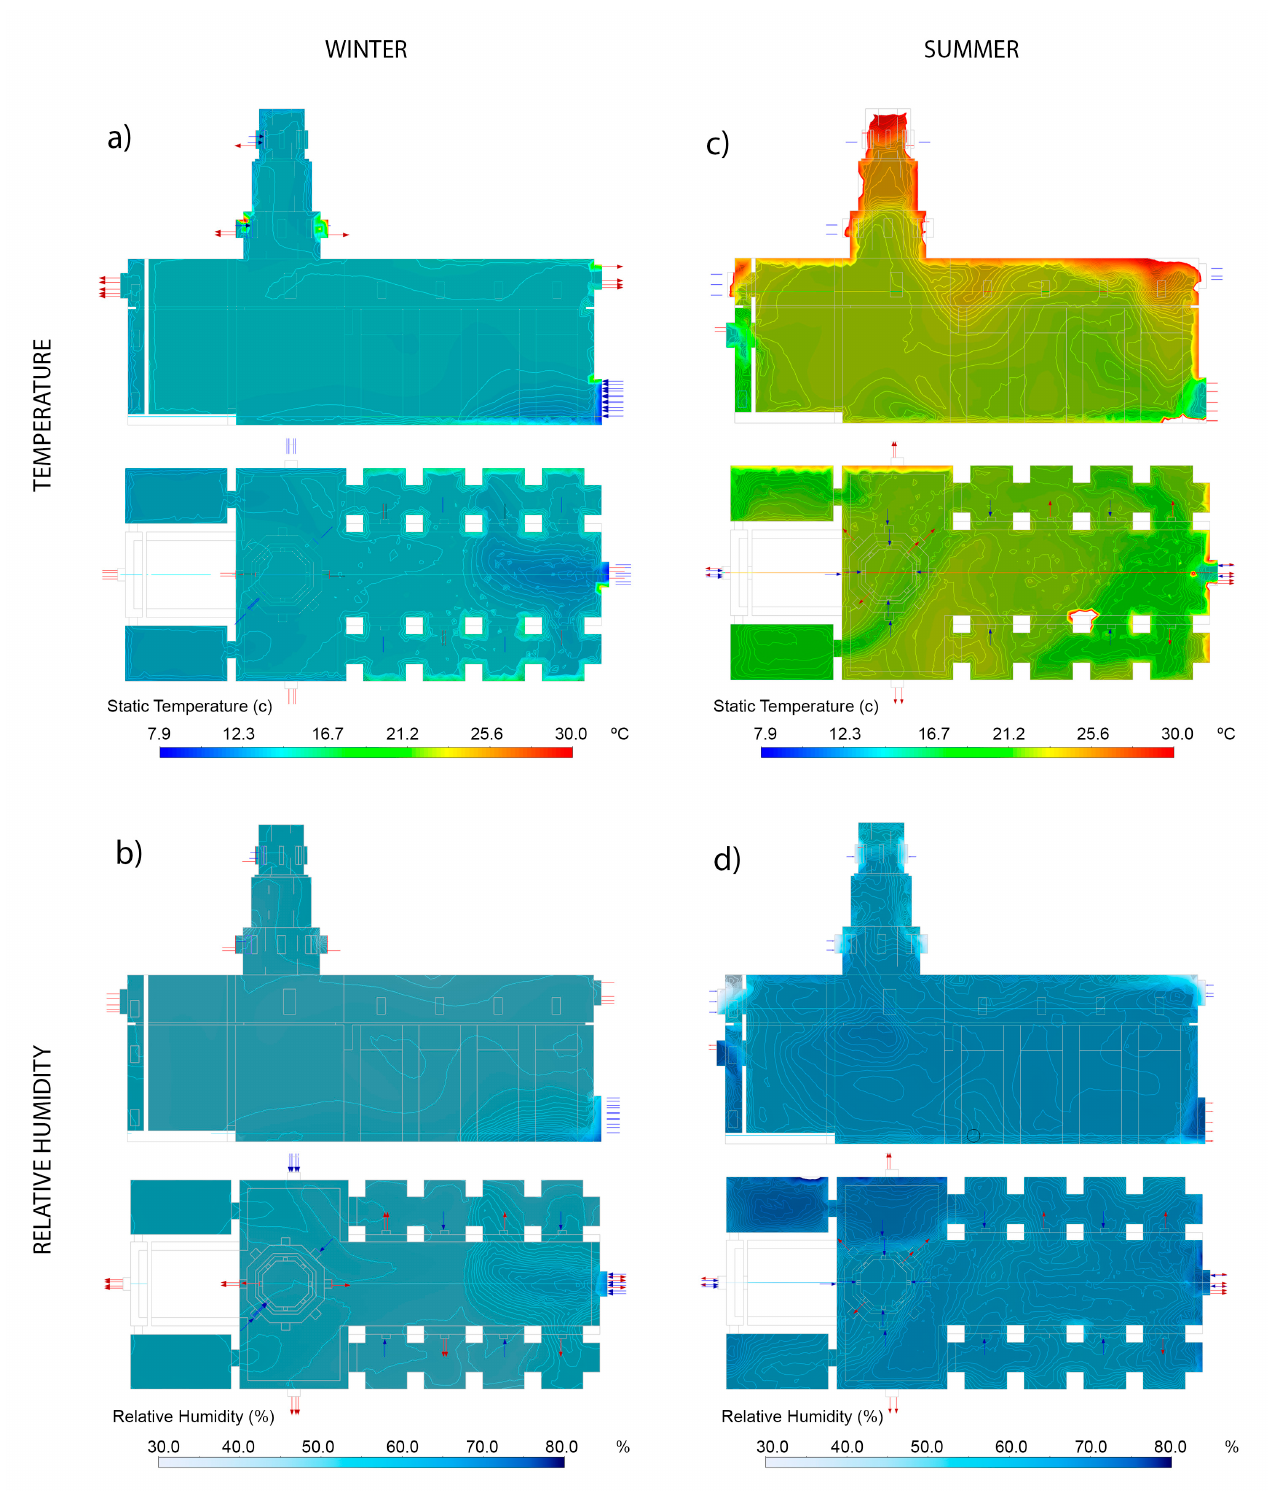
Figure 9. Comparison of CFD simulations. ( a ) T ( ◦ C) in winter, ( b ) RH (%) in winter, ( c ) T ( ◦ C) in summer, ( d ) RH (%) in